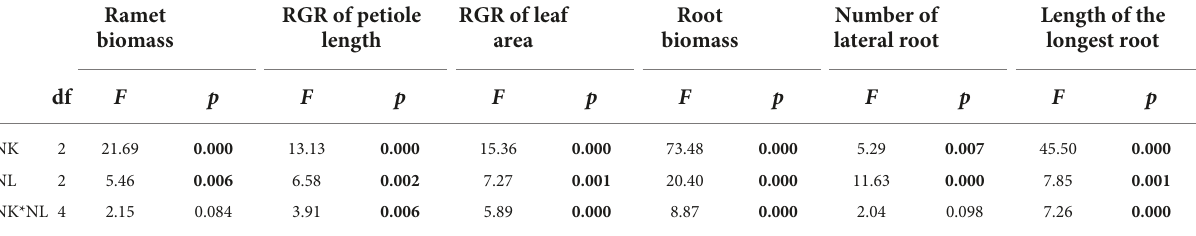
TABLE 1 ANOVA results for effects on neighbor kinship (NK) and nutrient level (NL) on ramet biomass traits and morphological traits of G. longituba. Ramet biomass